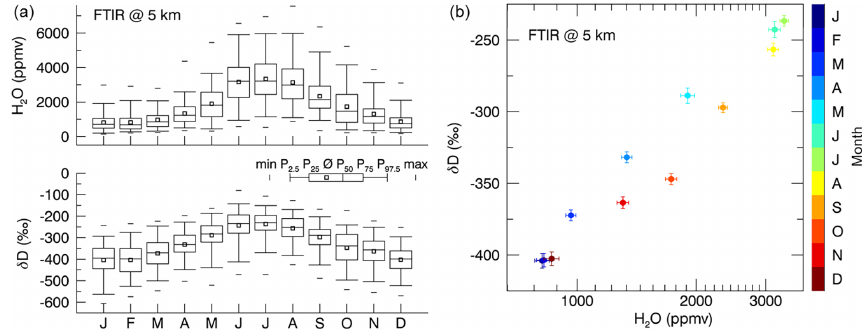
Figure 3. Seasonal cycles of water vapor and δ D in the free troposphere above Zugspitze: (a) multiannual monthly means and frequency distributions (percentiles P specified in the legend) of FTIR data at 5kma.s.l. and (b) {H 2 O, δ D} plot for multiannual monthly means, with error bars indicating standard errors of monthly means ( ±